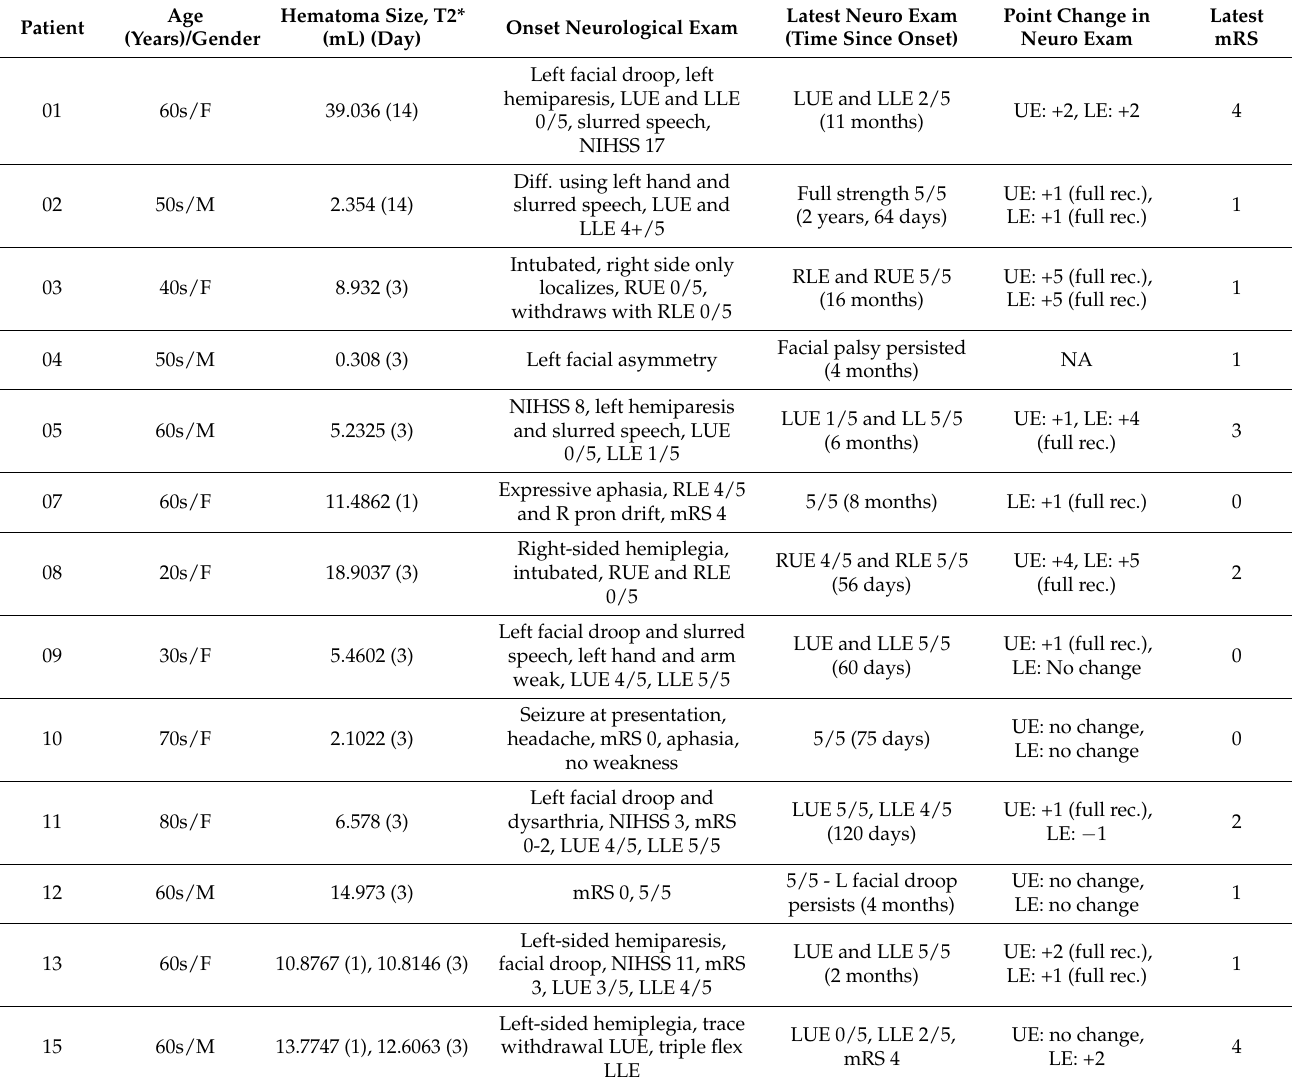
Table 1. Demographics and neurological exam